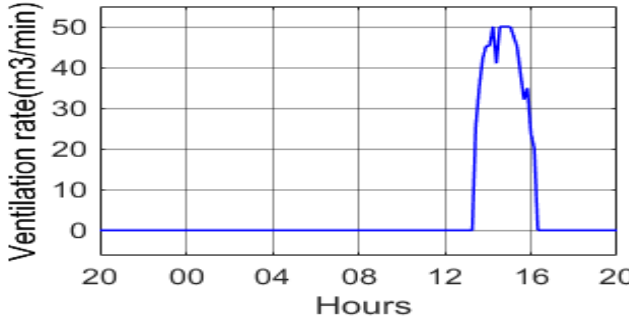
Figure 22. Ventilation rate.